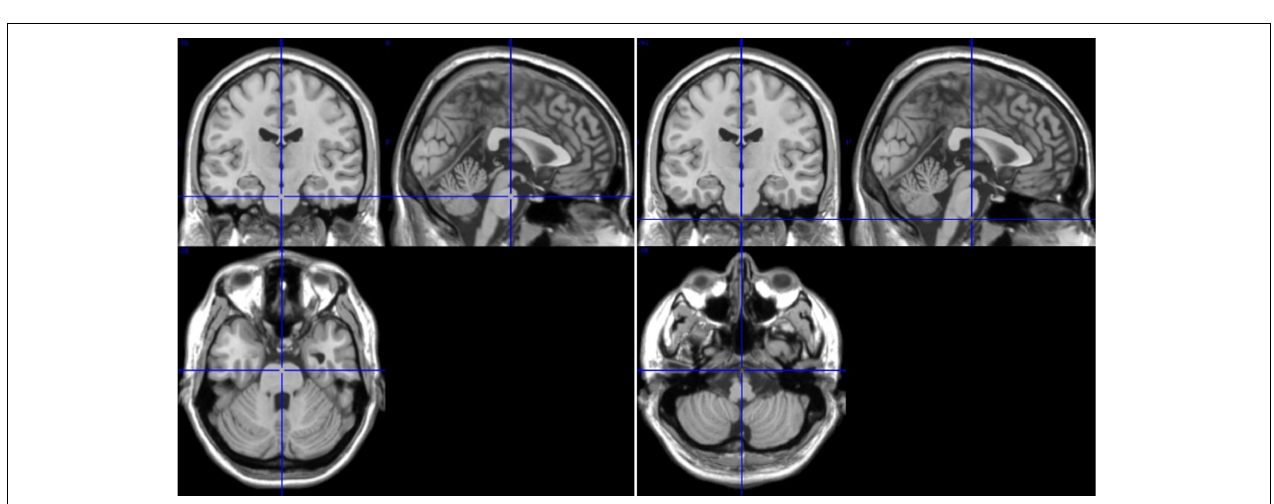
FIGURE 2 | T1-images from medial, sagittal and axial slices from rostral pons ROIs 91/92 ( left , Talairach space 0, 16, − 28) and caudal pons ROIs 107/108 ( right , Talairach space 0, 16, − 44). The difference between ROIs 91/92 and 107/108 is 16